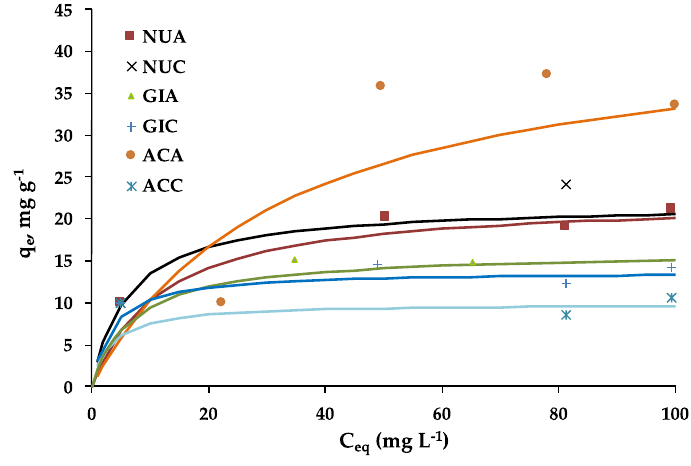
Figure 1. Fluoxetine adsorption isotherms.